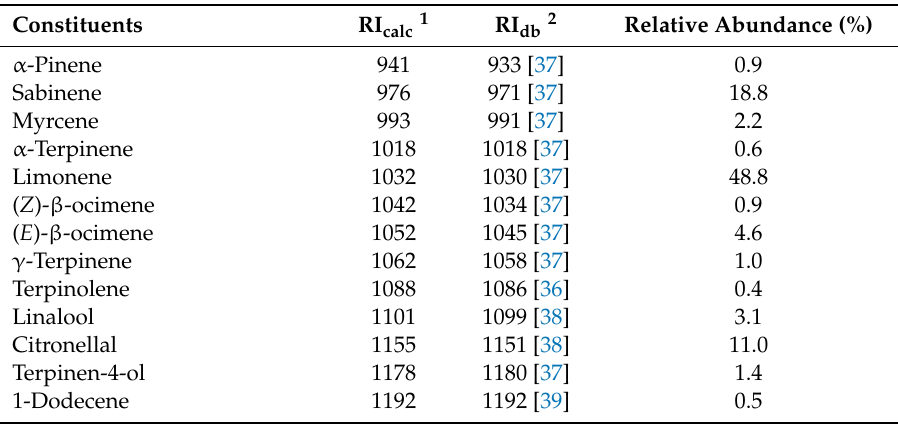
Table 1. The chemical constituents of Launaea taraxacifolia leaf essential